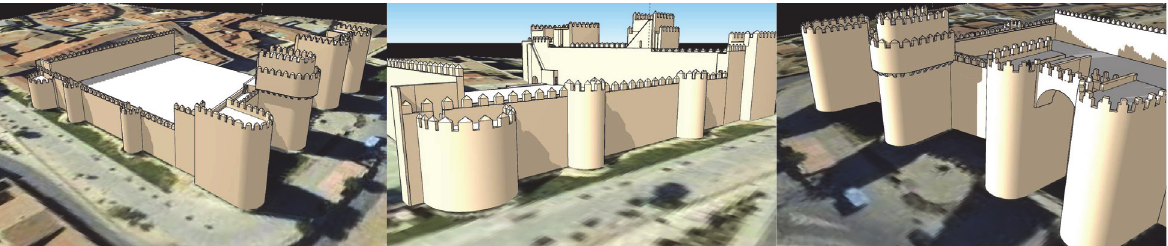
Figure 2. Different view of the reverse engineering process corresponding to the current